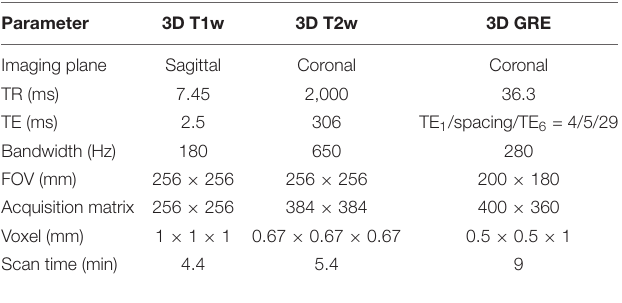
TABLE 1 | Imaging parameters utilized for the T1w, T2w, and GRE sequences.